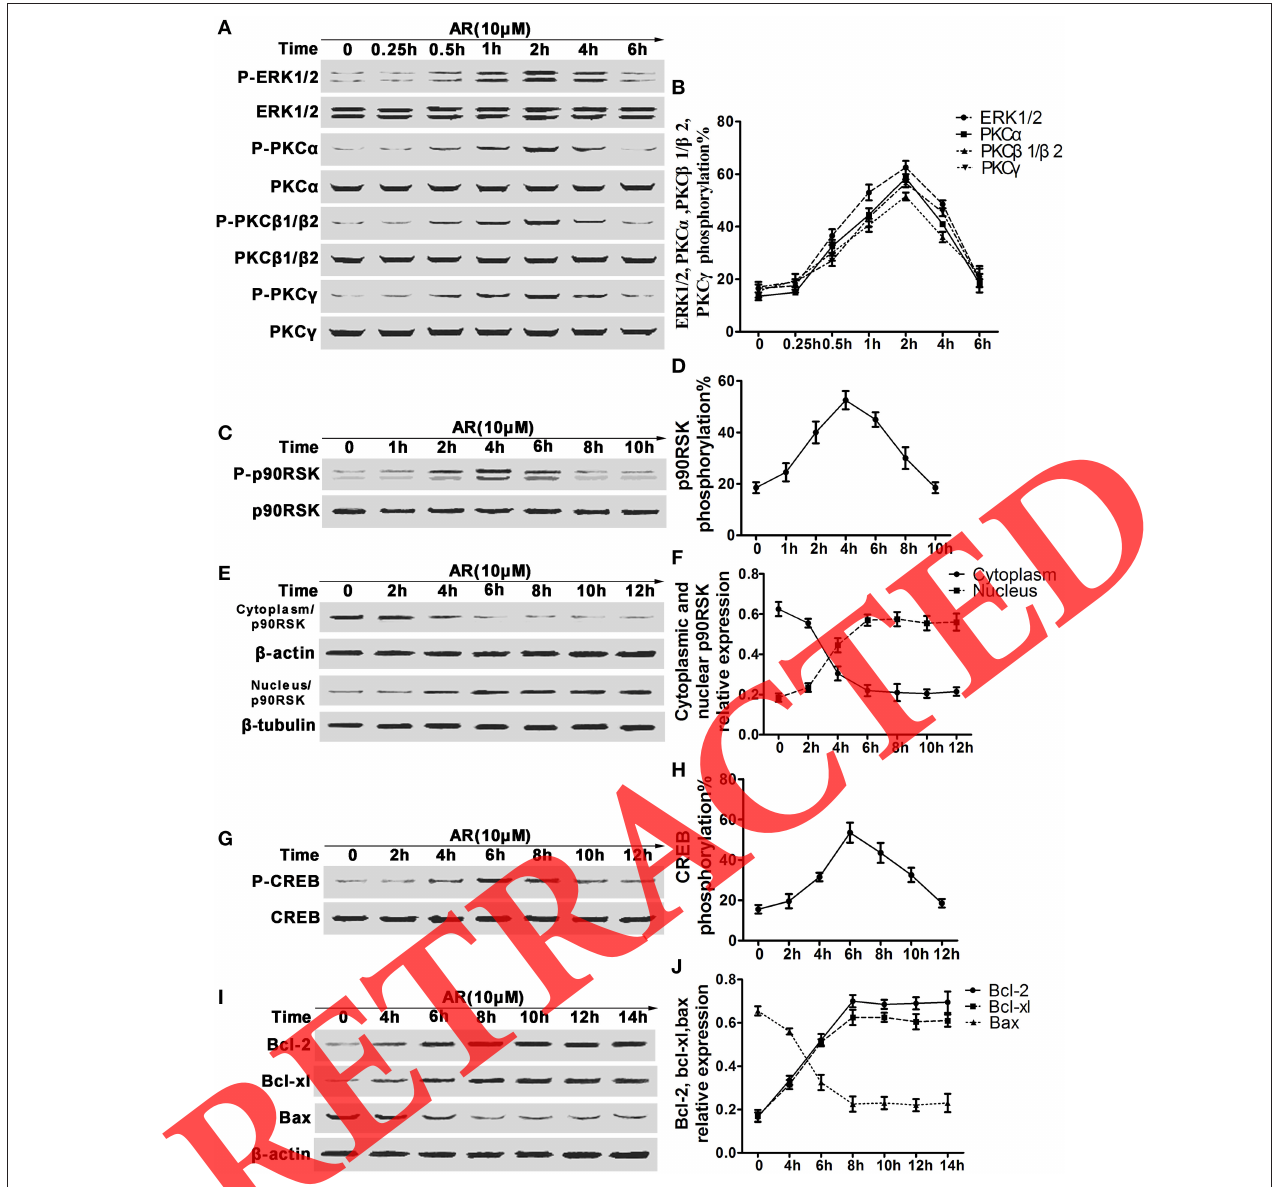
FIGURE 4 | The effect of AR on the phosphorylation of ERK1/2, cPKC, p90RSK, CREB and bcl-2, bcl-xl and bax expressions in primary cortical neurons after OGD/R. Primary cortical neurons were treated with 10 µ M AR for indicated time after OGD/R operation and then protein phosphorylation levels or expressions were determined by western blot assay. (A) Representative result of ERK1/2 and cPKC (PKC α , PKC β 1/ β 2, PKC γ ) phosphorylation alterations in neurons experiencing different time AR treatment, and data from four individual experiments were described in (B) . (C) Representative results of p90RSK phosphorylation alterations in neurons experiencing different time AR treatment, and this time-kinetic data were described in (D) . (E) Representative result of p90RSK nucleus-cytoplasm distribution alterations in neurons experiencing different time AR treatment, and this time-kinetic data were described in (F) . (G) Representative result of CREB phosphorylation alterations in neurons experiencing different time AR treatment, and this time-kinetic data were described in (H) . (I) Representative result of bcl-2, bcl-xl, and bax expressions changes in neurons experiencing different time AR treatment, and this time-kinetic data were described in (J) .